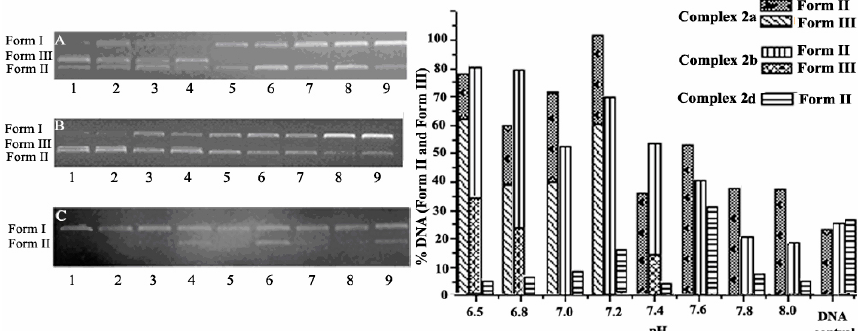
Figure 4. Histograms and electropherograms (the right side figure) representing cleavage of pUC19 plasmid DNA (0.008 µg/µL) in different pH buffer of 2a (6.25 × 10 − 7 mol/L), 2b (3.13 × 10 − 7 mol/L) and 2d (6.25 × 10 − 7 mol/L) (5 mM Tris-HCl/10 mM NaCl) at 37 °C for 6 h. ( A ) Complex 2a; Lanes 1–8: pH = 6.5, 6.8, 7.0, 7.2, 7.4, 7.6, 7.8, 8.0; Lane 9 = DNA control, respectively. ( B ) Complex 2b and Lanes 1–8: pH = 6.5, 6.8, 7.0, 7.2, 7.4, 7.6, 7.8, 8.0 Lane 9 = DNA control, respectively; ( C ) complex 2d; Lanes 1–8: pH = 6.5, 6.8, 7.0, 7.2, 7.4, 7.6, 7.8, 8.0; Lane 9 = DNA control,